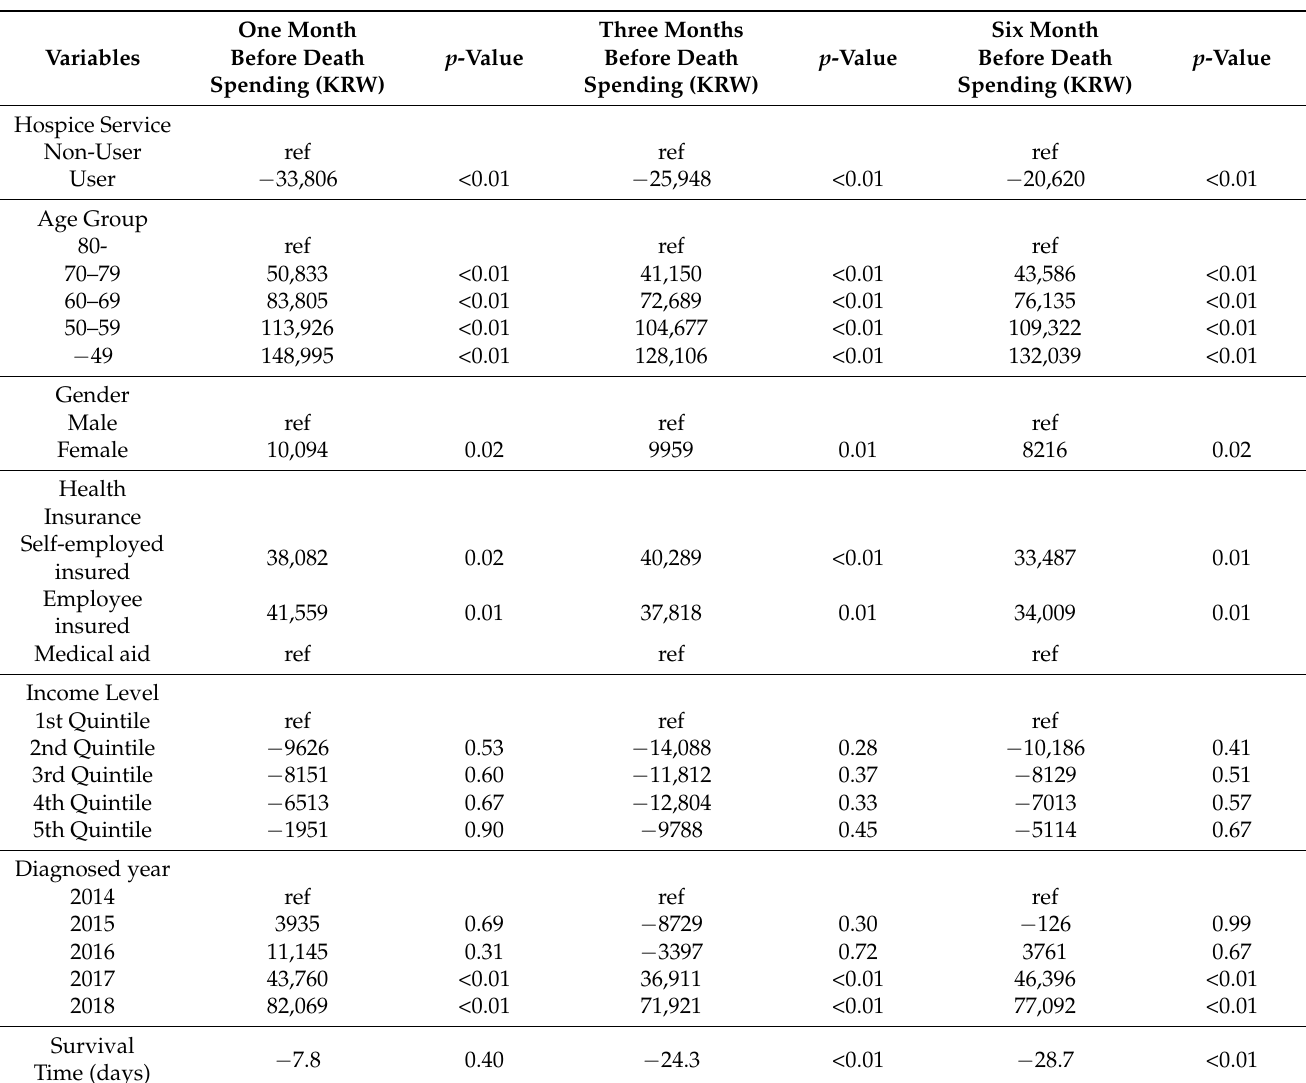
Table 2. Result of GLM analysis: association between hospice service and hospital charges per day among deceased lung cancer patients at their end of